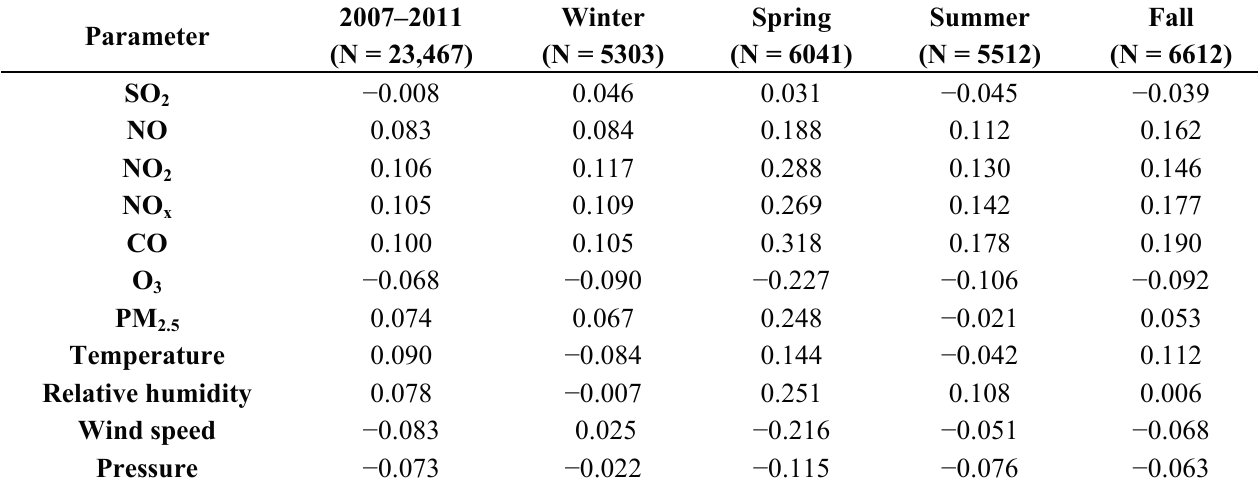
Table 1. Pearson correlation coefficients of hourly Total Gaseous Mercury (TGM) concentration with other parameters (all significant at p < 0.05 except shaded